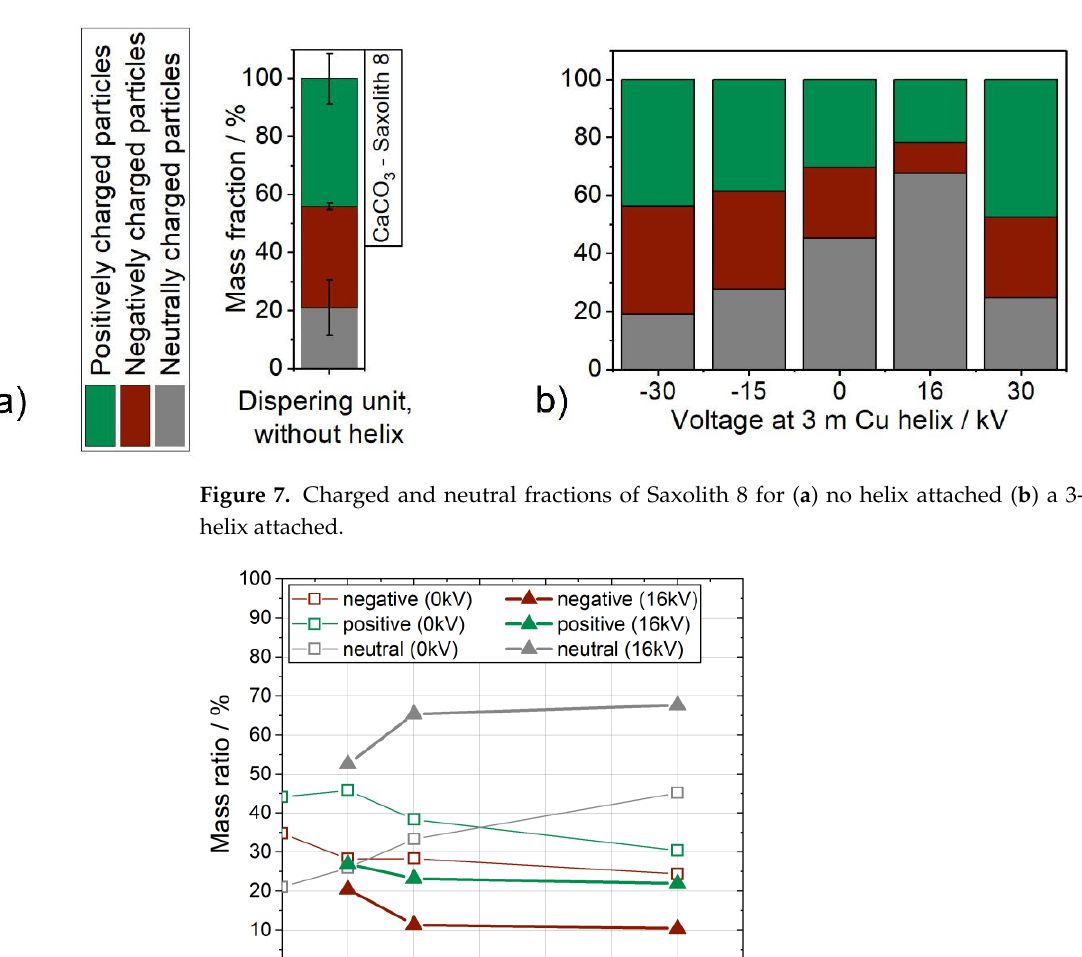
Figure 8. Charged and neutral mass fractions of the particles with no external potential (0 kV) and potential at the PZNC (16 kV) of Saxolith.